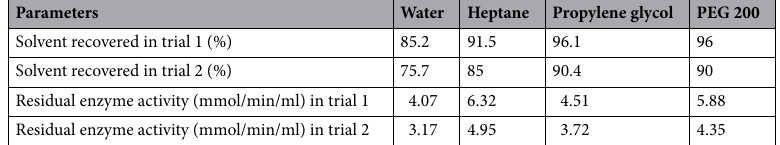
Table 3. Recycling of the used solvent-enzyme mixture in the fiber opening process.